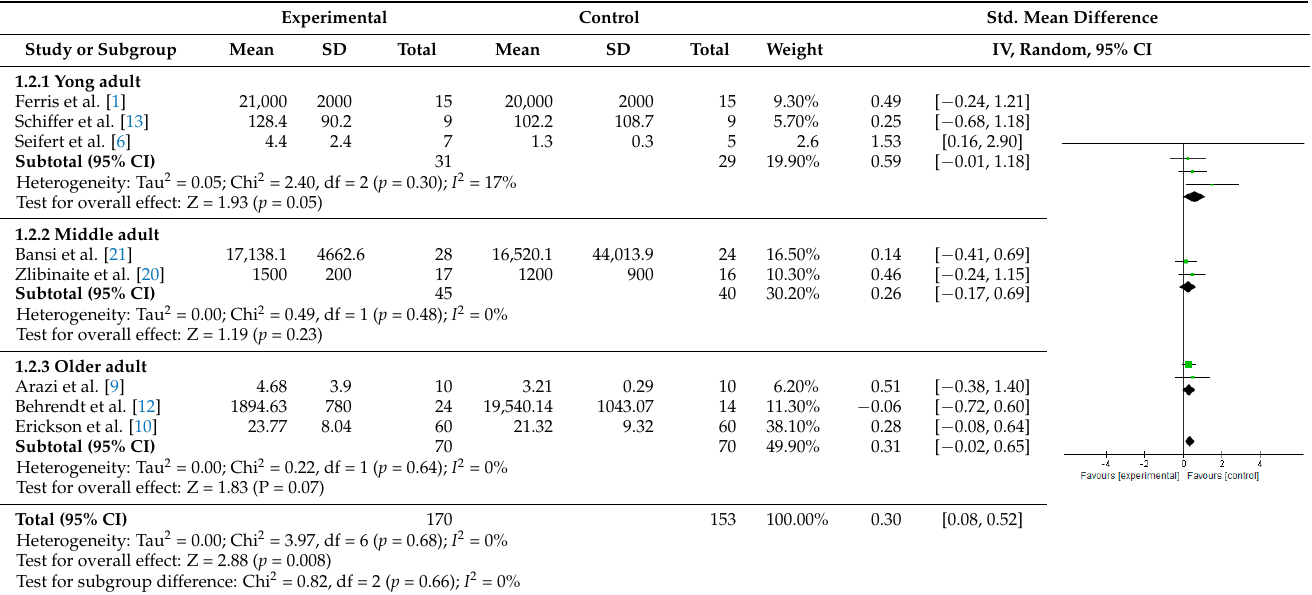
Table 5. Standardized mean differences and forest plot of impact of endurance exercise on BDNF levels in different populations.